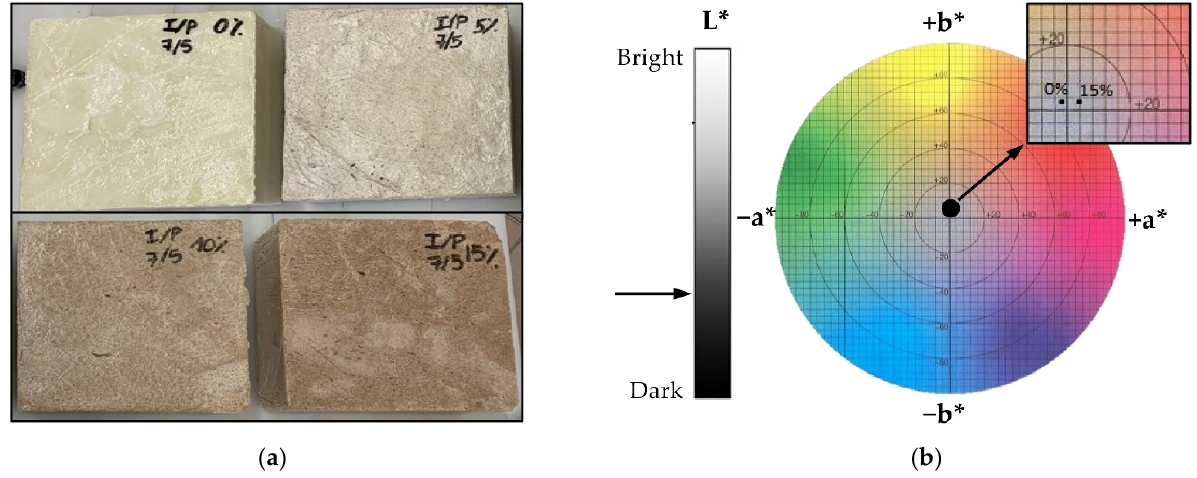
Figure 9. Color variation of polyurethane samples induced by the addition of cork waste: visual macroscopic evidence of polyurethane containing, from left to right, 0 wt%, 5 wt%, 10 wt%, 15 wt% of cork ( a ) and colorimetry values ( b ). Table 4. Colorimetry test results for polyurethanes.